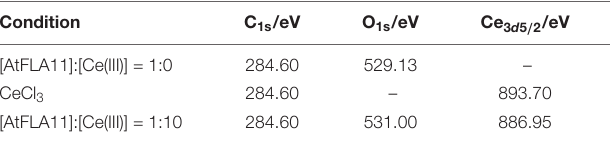
TABLE 2 | The average orbital binding energies of C 1s , O 1s and Ce 3 d 5 / 2 in AtFLA11 incubated with Ce(III) at different concentrations. Condition C 1s /eV O 1s /eV